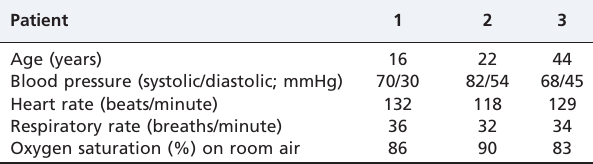
Table 1 - Clinical data collected on the day of injury.